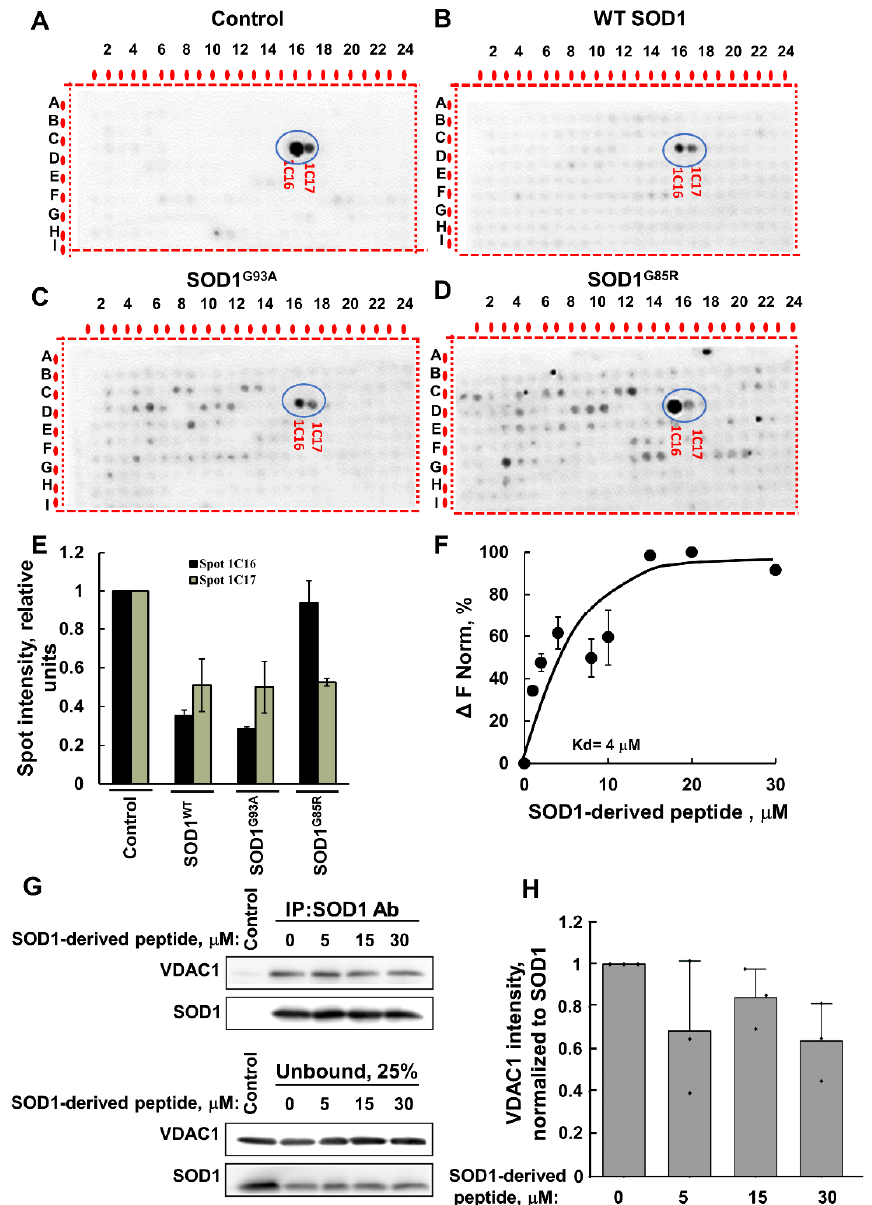
Figure 2. VDAC1 interaction with SOD1-derived peptides is reduced by WT and mutant SOD1. VDAC1 (64 nM) was pre-incubated for 1 h without ( A ) or with 160 nM of SOD1 WT ( B ), SOD1 G93A ( C ), or SOD1 G85R ( D ), followed by incubation for 4 h with the peptide array and then blotted with anti- VDAC1 antibodies, as in Figure 1C. SOD1-derived sequences are circled. ( E ) The intensity of the peptide spots 1C16 and 1C17 (circled) was analyzed using Image J. ( F ) Fluorescently labeled purified VDAC1 (138 nM) was incubated with the SOD1-derived (1C16) peptide (1–30 µ M) for 30 min at 37 ◦ C; then, MST analysis was performed, and the revealed K d is indicated. ( G ) Pull down with anti- SOD1 antibody was performed by incubating recombinant VDAC1 and SOD1 proteins (2 µ g each) with increasing concentrations of SOD1-derived peptide (0, 5, 15, and 30 µ M). Immunoblotting was used to determine the levels of SOD1 G93A and VDAC1 in the bound and unbound fraction of each immunoprecipitation experiment. Data indicate one representative membrane out of 3 independent experiments. ( H ) Quantification of immunoblotting bands with ImageJ software. Quantification analysis of the relative VDAC1 intensity was performed with one-way ANOVA. Bars represent mean ±